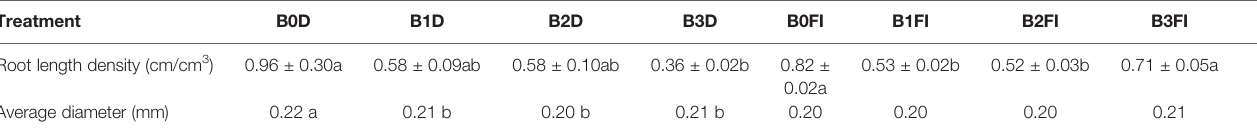
Frontiers in Plant Science |